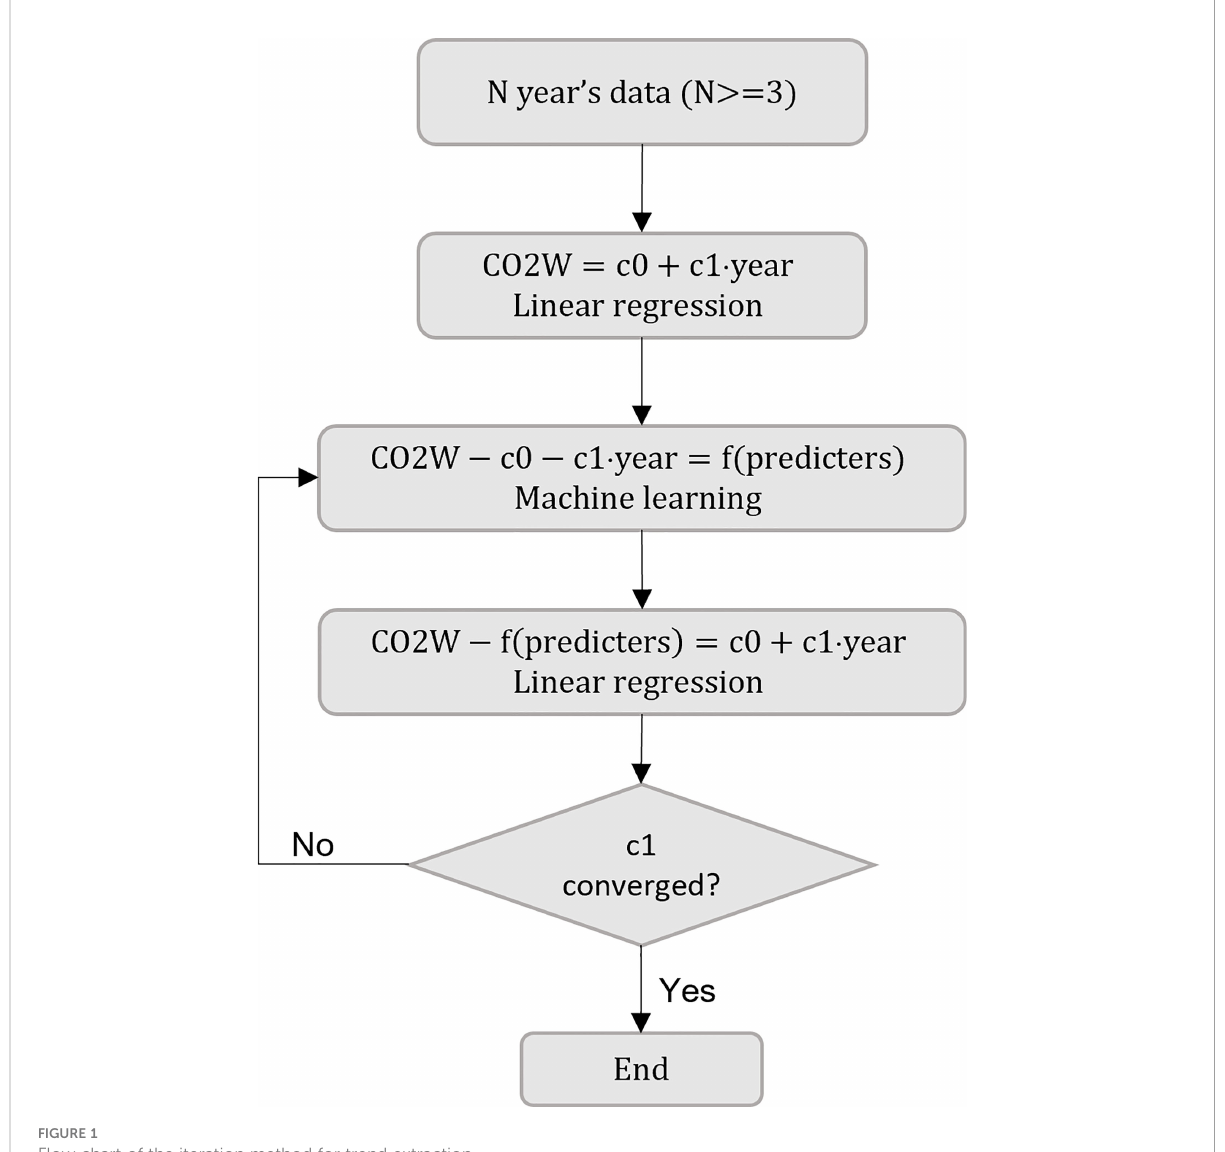
FIGURE 1 Flow chart of the iteration method for trend